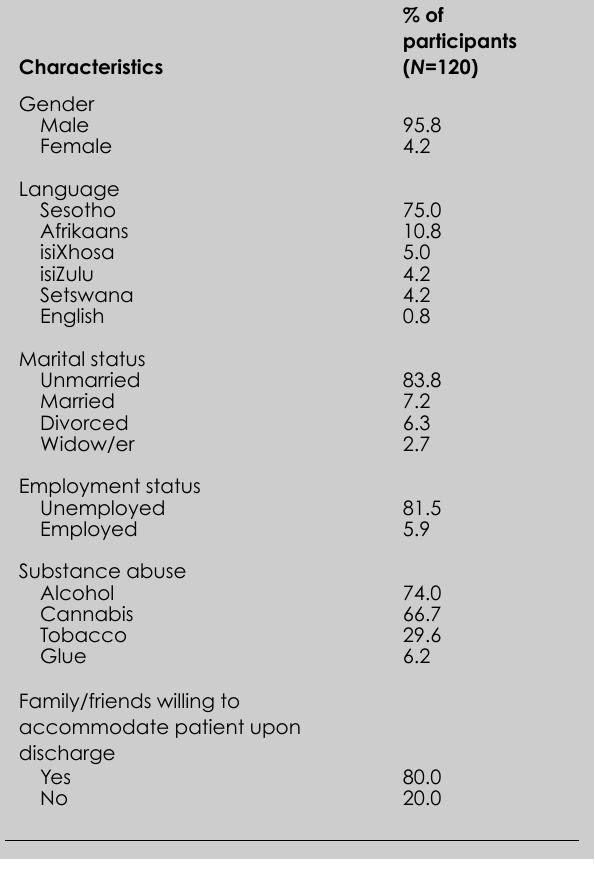
Table I. Socio-demographic characteristics of participants